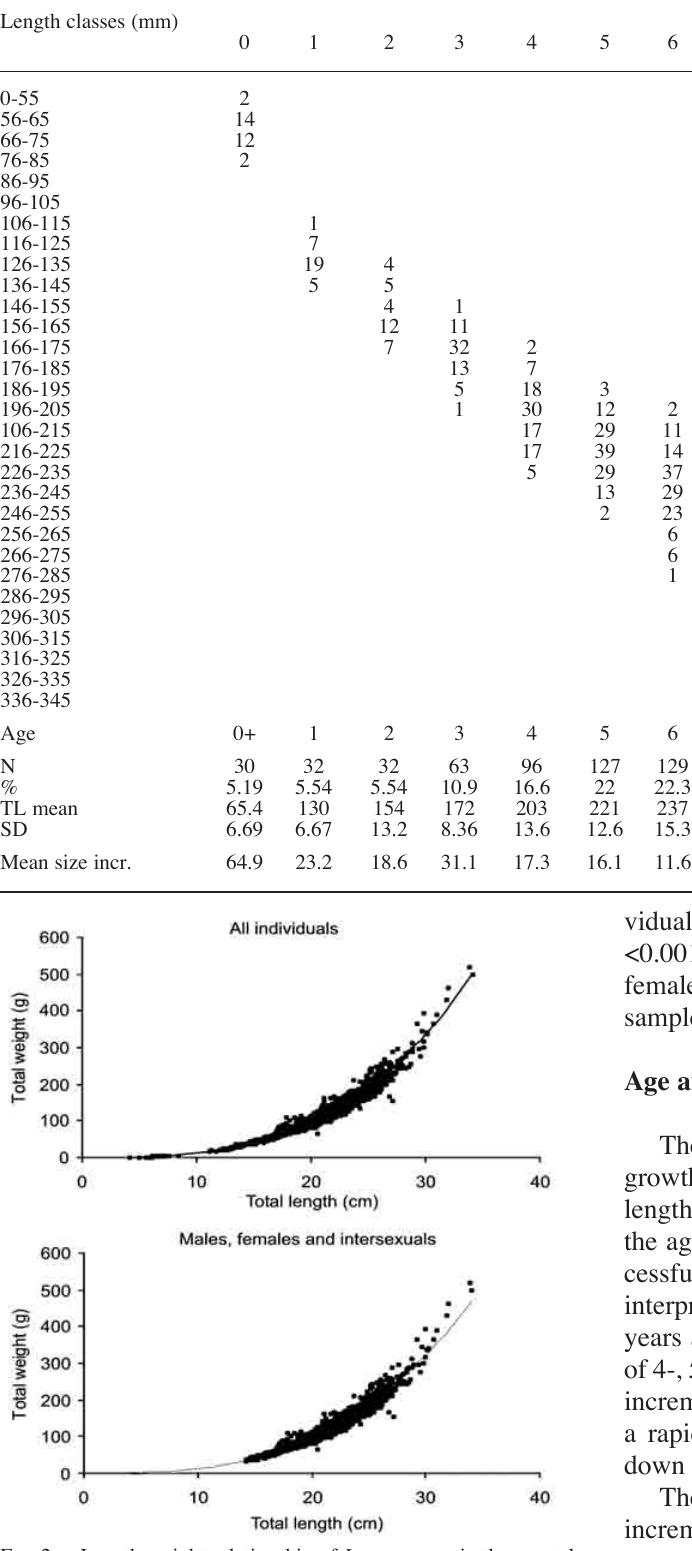
POPULATION PARAMETERS OF L. MORMYRUS IN THRACIAN SEA